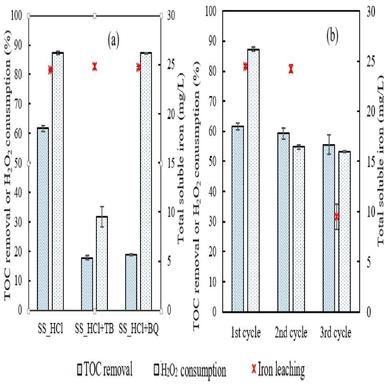
Photocatalytic oxidation of 4-CP: a) Effect of Radical scavenger and b) Catalyst reusability study (initial TOC of 4-CP wastewater ¼ 119 mg/L, catalyst dose ¼ 1 g/L, H2O2 dose ¼ 20.3 mM, initial reaction pH ¼ 4.4, TB ¼ 20 mM, BQ ¼ 20 mM and run time ¼ 2 h).